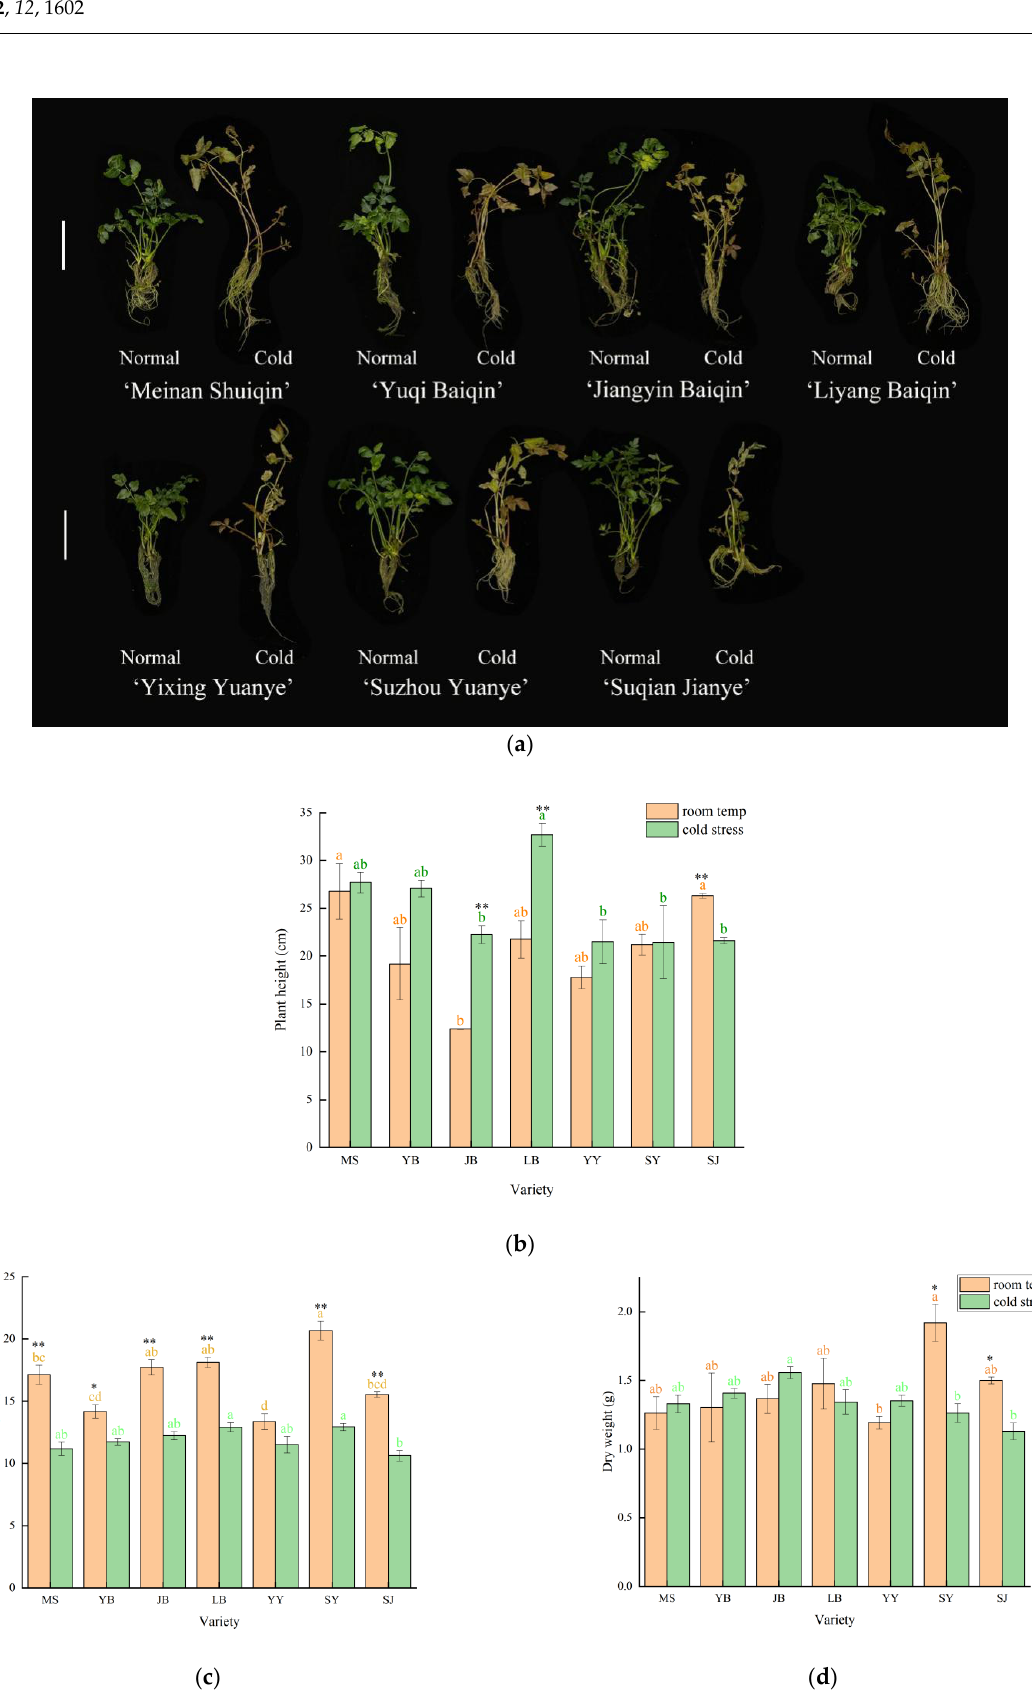
Figure 2. Architecture and biomass assimilation of O. javanica cultivars in different temperatures. Different letters with the same color indicate the significance of the difference at the same temperature. Asterisk indicates the significance of the difference of a different temperature on the same cul- tivar.* significant differences, p < 0.05; ** extremely significant differences, p < 0.01. ( a ) Architecture of different O. javanica cultivars after 22 days of growth in the simulated livestock wastewater at different temperatures. Normal: room temperature; Cold: cold stress. ( b ) Plant height of different O. javanica cultivars after 22 days of growth. ( c ) Fresh matter biomass of different O. javanica culti- vars after 22 days of growth. ( d ) Dry matter biomass of different O. javanica cultivars after 22 days of growth. MS: ‘Meinan Shuiqin’; YB: ‘Yuqi Baiqin’; JB: ‘Jiangyin Baiqin’; LB: ‘Liyang Baiqin’; YY: ‘Yixing Yuanye’; SY: ‘Suzhou Yuanye’; SJ: ‘Suqian Jianye’. 3.2. ‘Suzhou Yuanye’ and ‘Liyang Baiqin’ Showed the Best N Removal Ability at Room Temperature, but Cold Stress Inhibited the N Removal Ability of ‘Liyang Baiqin’ To investigate the TN removal performance of the seven O. javanica cultivars grown in simulated livestock wastewater, the concentrations of TN and NH 4+ -N in the water were monitored on day 1, day 3, day 5, day 7, day 12, day 17, and day 22 (Figure 3). At room temperature, ‘Suzhou Yuanye’ and ‘Liyang Baiqin’ showed the strongest N removal effi- ciency. After 22 days of growth, the TN and NH 4+ contents in be akers with ‘Suzhou Yuanye’ were 282.71 ± 3.74 mg/L and 265.67 ± 4.19 mg/L, respectively, and the contents in beakers with ‘Liyang Baiqin’ were 278.50 ± 5.14 mg/L and 275.00 ± 2.94 mg/L, respectively. There were no significant differences between the TN con tents of the beakers with ‘Su- zhou Yuanye’ and ‘Liyang Baiqin’ at room temperature on day 5, day 12, day 17, and day 22. After 22 days, ‘Liyang Baiqin’ removed the most TN with a reduction rate of 44.30 ± 1.03 %, which was 1.3 times the reduction rate of ‘Suqian Jianye’ (34.67 ± 1.87%), with a significant difference. The N removal performance at room temperature indicated that the N removal efficiency was significantly different between cultivars, and cultivar differ- ences should be considered before employing O. javanica for livestock wastewater phy- toremediation applications. ‘Liyang Baiqin’ and ‘Suzhou Yuanye’ were more suitable for N purification from wastewater than the other cultivars in spring or autumn, which are the optimum growing seasons for O. javanica , while ‘Suqian Jianye’ and ‘Yixing Yuanye’ had the worst N removal efficiency and should be avoided for this purpose.